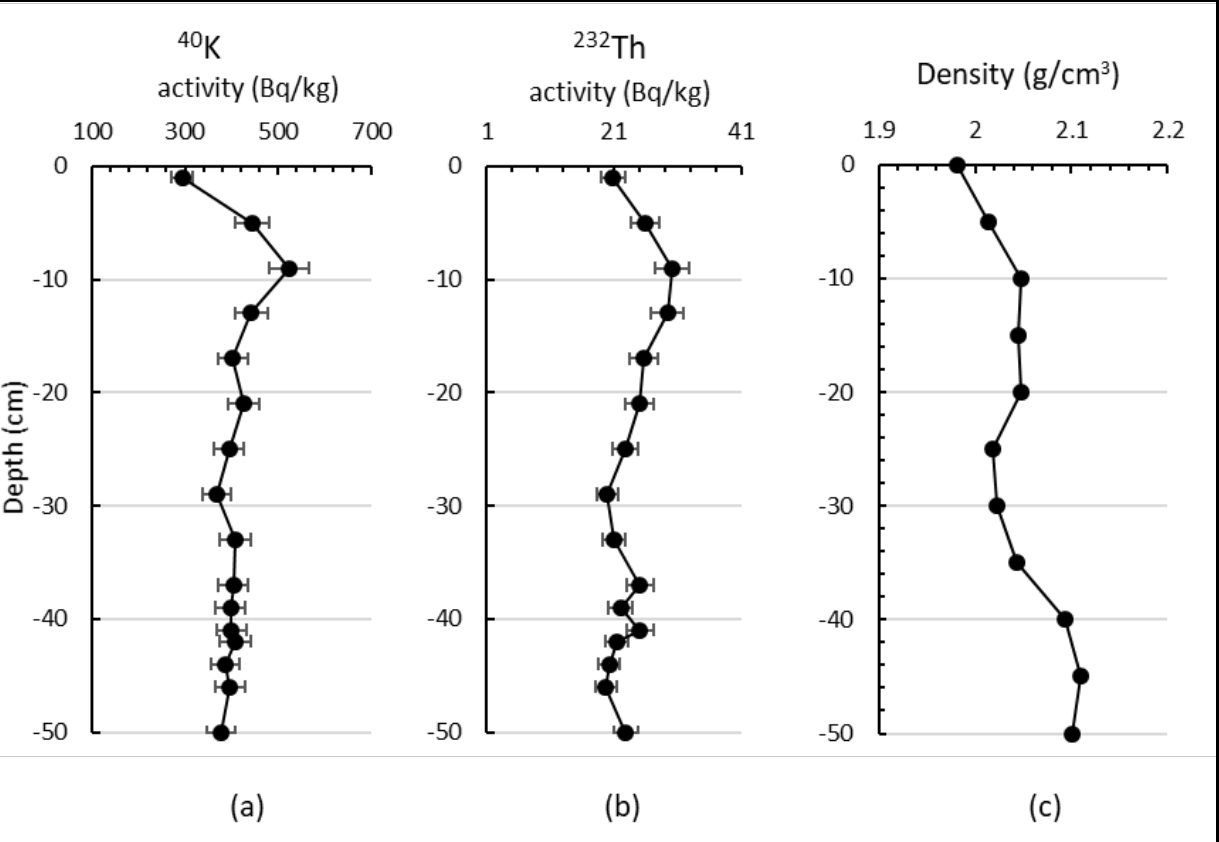
Figure 2. Vertical distribution of ( a ) 40 K; ( b ) 232 Th and ( c ) Density (g cm −3 ) in the sediment core of the Limoncocha lagoon.